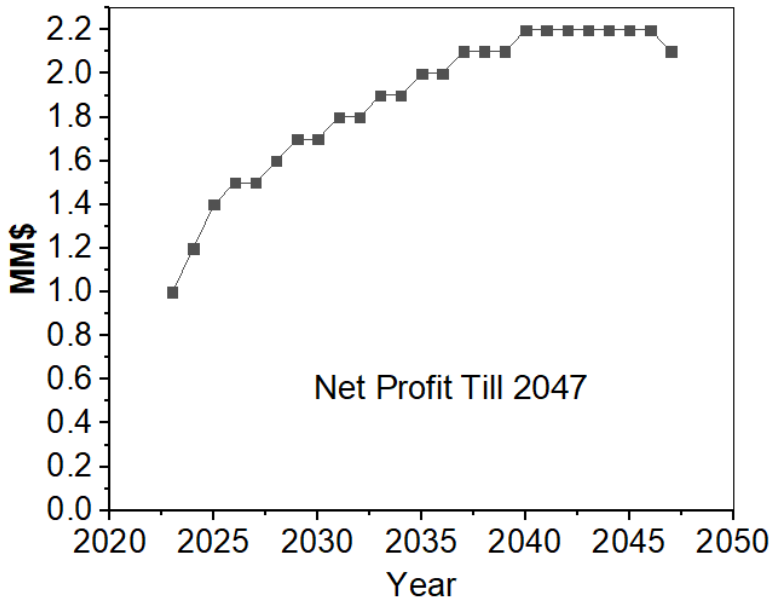
Figure 16. Net profit for bioethanol plant.